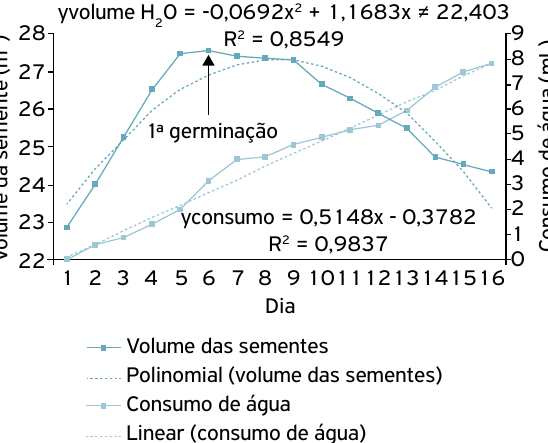
Figura 2. Teste de embebição e volume das sementes de Schinus terebinthifolius durante o seu desenvolvimento germinativo.